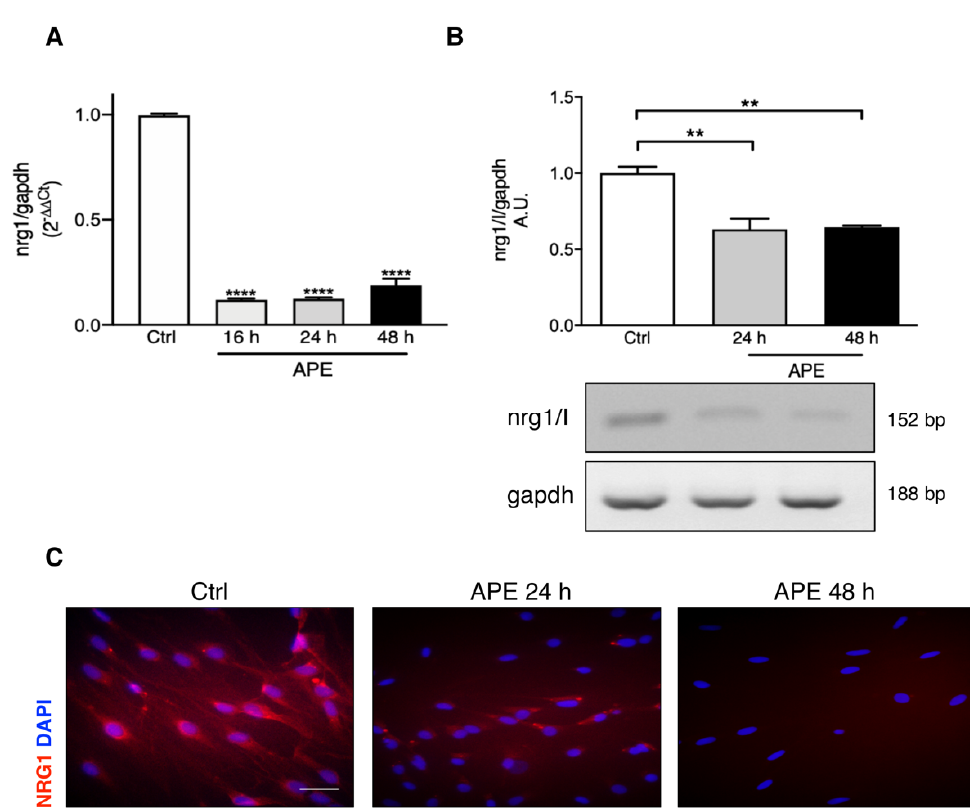
Figure 2. NRG1 transcript and protein levels are modulated by M2 agonist APE. ( A ) M2 receptor agonist APE downregulates nrg1 transcript levels already after 16 h of treatment, up to 48 h of exposure (APE 16 h, 24 h, 48 h vs. Ctrl: **** p < 0.0001; n = 3) ( B ) RT-PCR shows SCs express the nrg1 type I isoform; M2 selective activation significantly downregulates this isoform after 24 h and 48 h of APE treatment (APE 24 h, 48 h: ** p < 0.01, n = 3). ( C ) Immunostaining shows a gradual reduction in NRG1 protein expression in SCs treated with the M2 agonist APE, until it disappears completely after 48 h of exposure (scale bar = 100 µm).